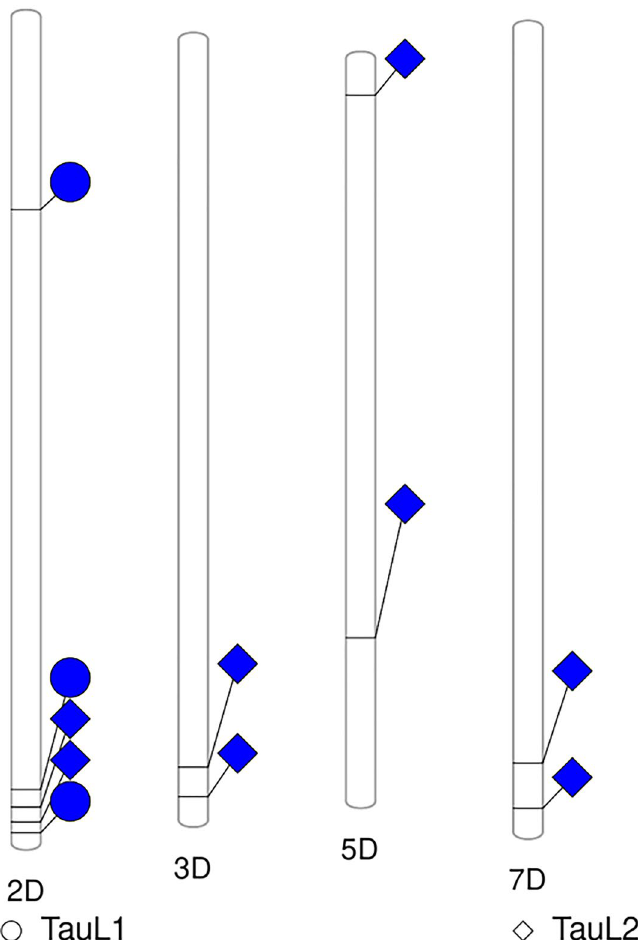
Figure 4. Chromosome phenogram plots of significant LHD-SNP associations detected by GWAS in TauL1 (circles) and TauL2 (diamonds) lineages of Aegilops tauschii